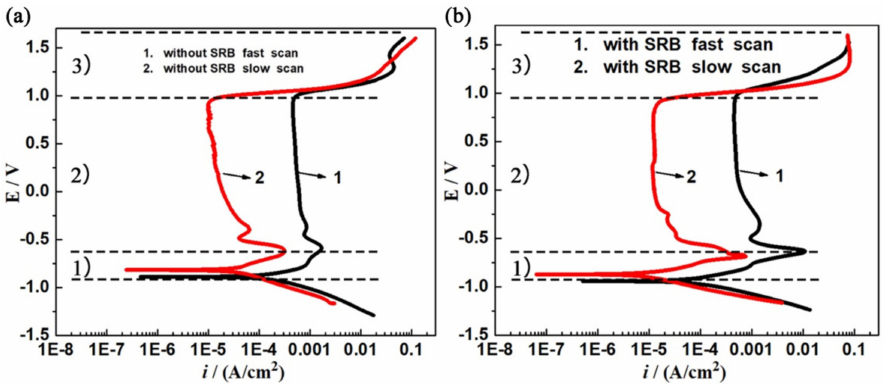
Figure 6. Fast (50 mV/s) and slow (0.5 mV/s) scan polarization curves of X80 steel under different conditions: ( a ) without SRB, ( b ) with